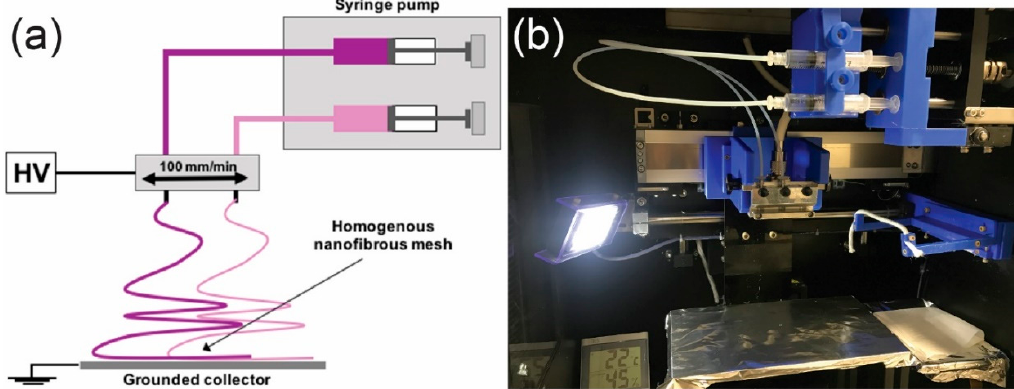
Figure 1. ( a ) Basic layout of the setup utilized for electrospinning, which consists of a high voltage power supply (HV), two syringe pumps, and a grounded collector; ( b ) a photo of experimental setup used in experiments.